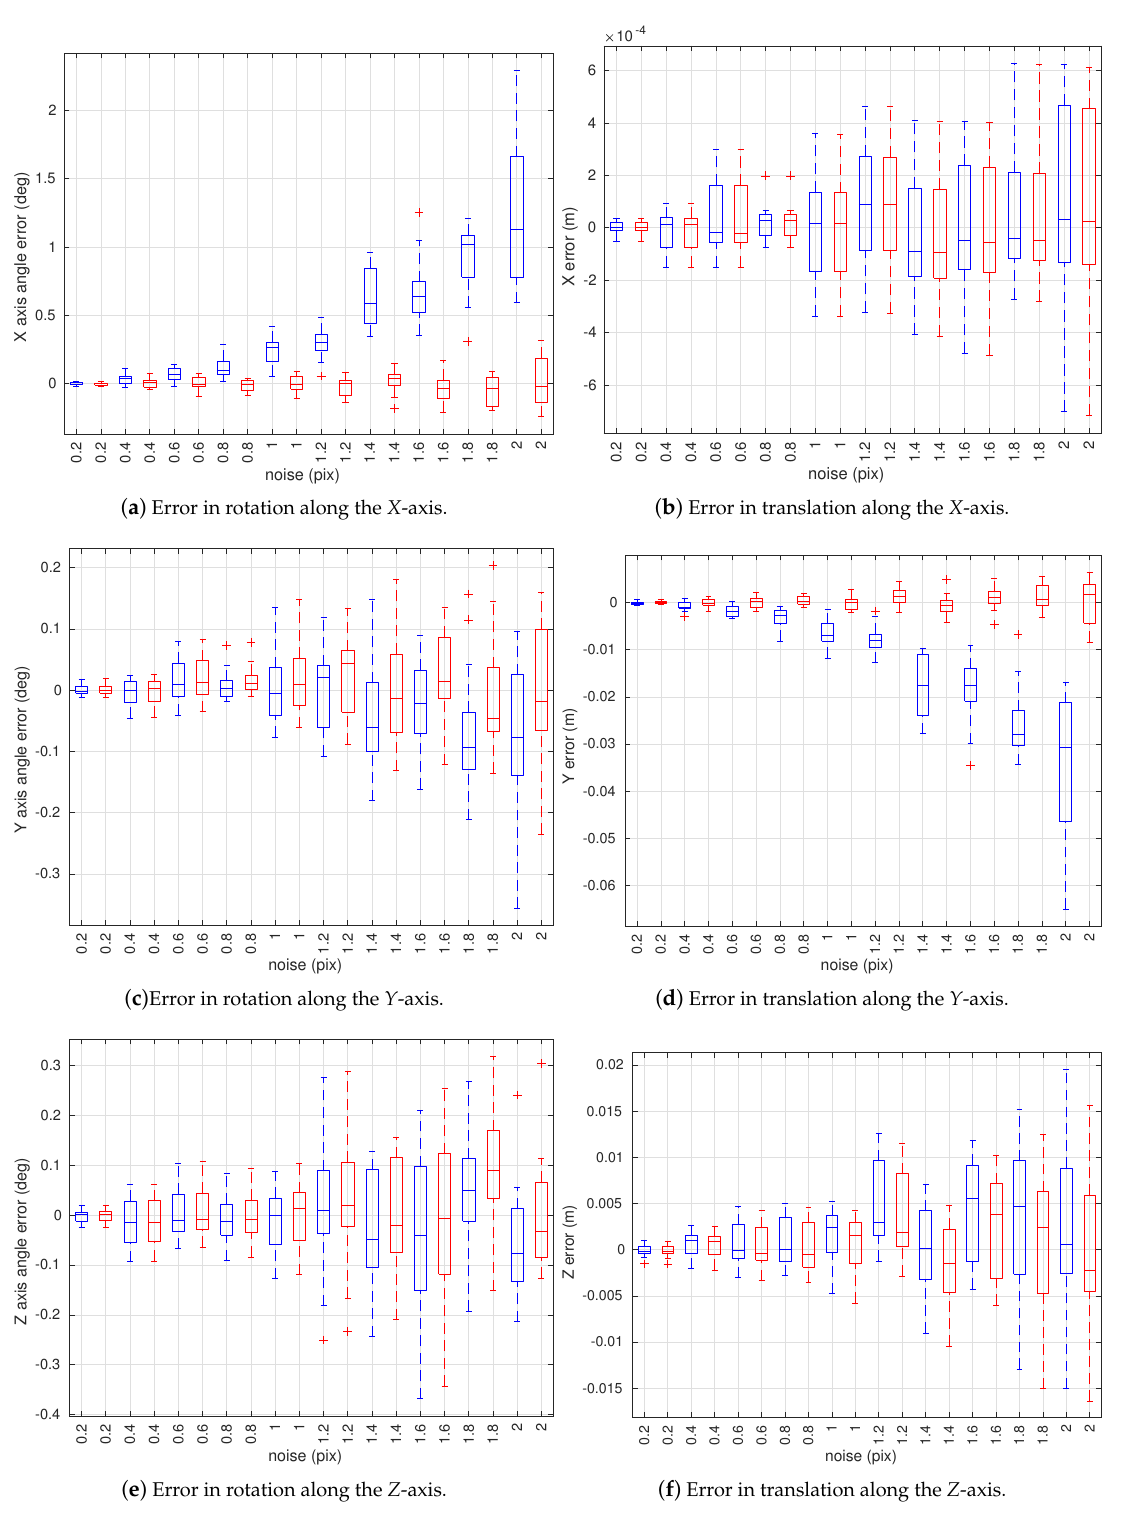
Figure 7. Box plots of estimation errors in camera extrinsic parameters w.r.t. camera observation noise. The box plots in blue represent estimation results using the conventional method [19] and red ones are of the proposed method without joint